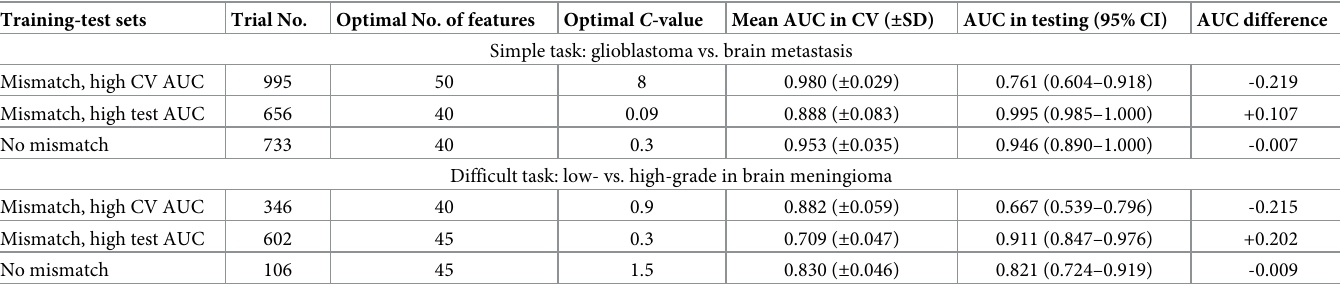
Table 2. Model performance estimate and generalization gap according to the level of task difficulty in some representative training-test set pairs. Training-test sets Trial No.